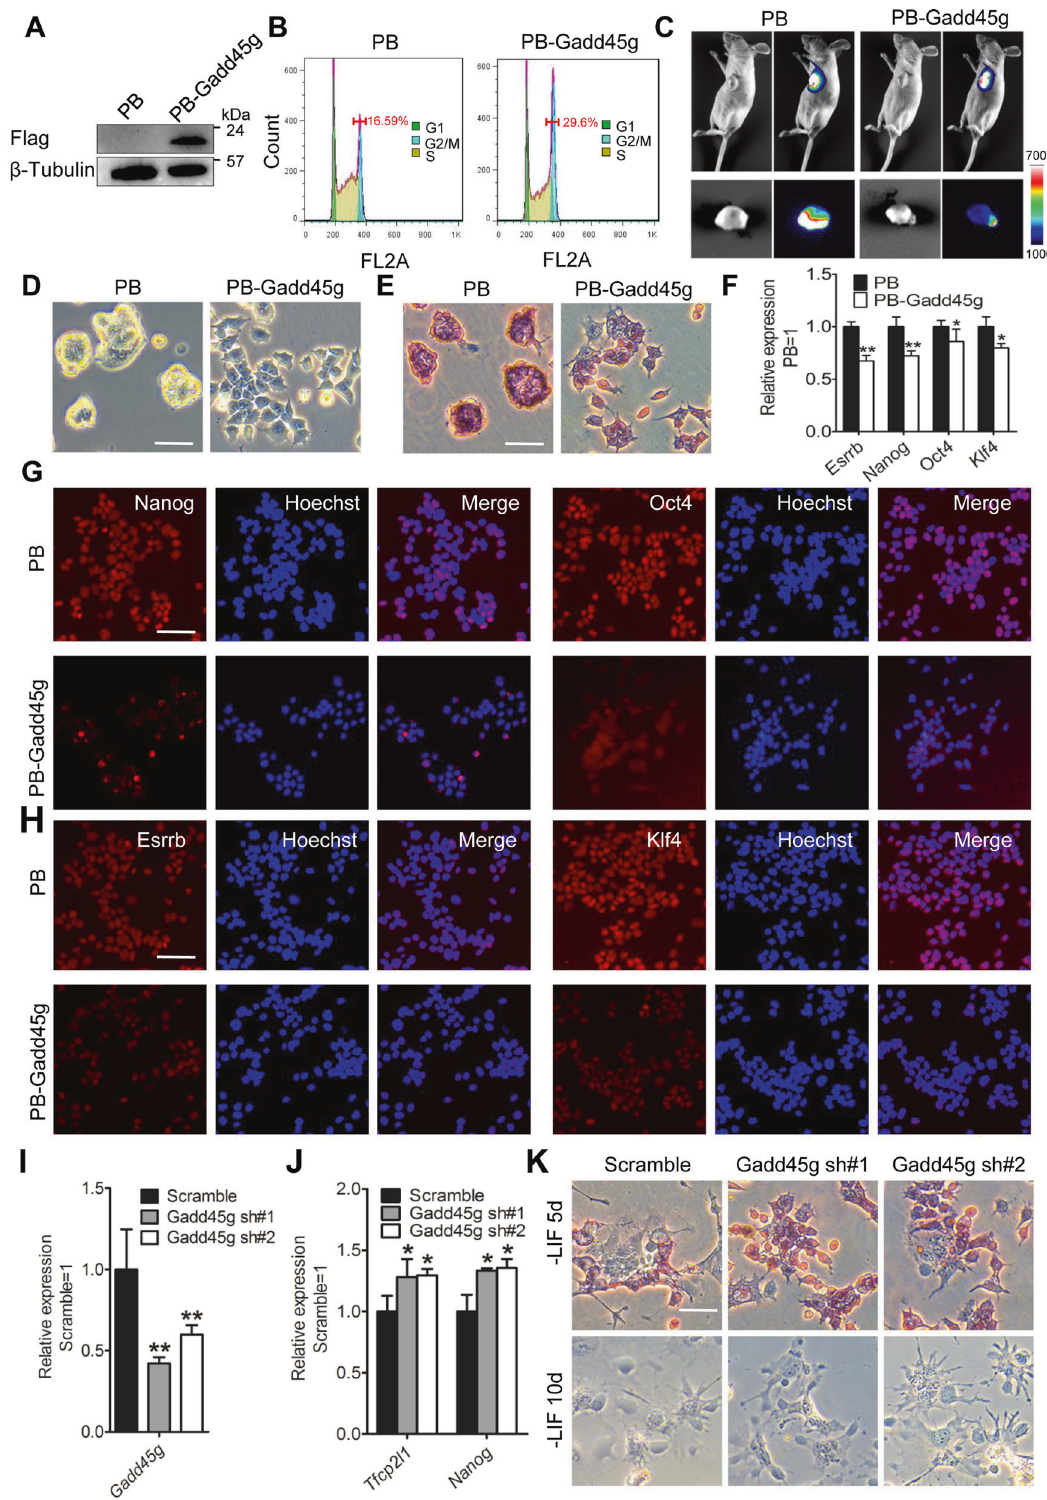
(Fig. 3F and G). At the same time, we also evaluated the expression of these genes in Gadd45a- and Gadd45b-overexpressing mESCs and observed that most of them are signi fi cantly induced (Fig. S4). Next, to test whether we can observe opposite expression patterns after Gadd45g was downregulated, we detected the transcripts of these candidates in Gadd45g shRNA cells. Only